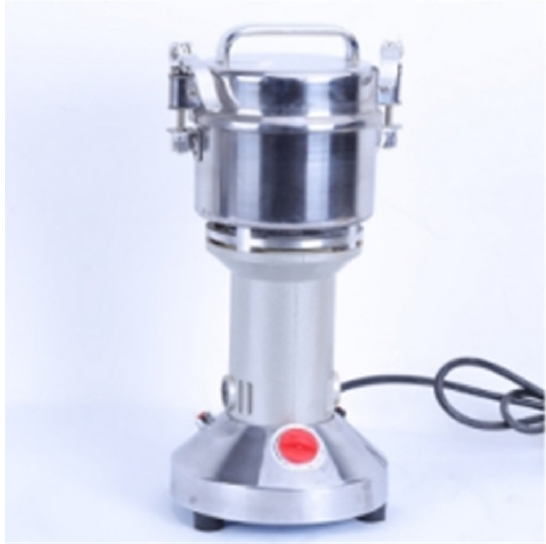
Figure 2. Small high-speed multifunctional pulverizer.